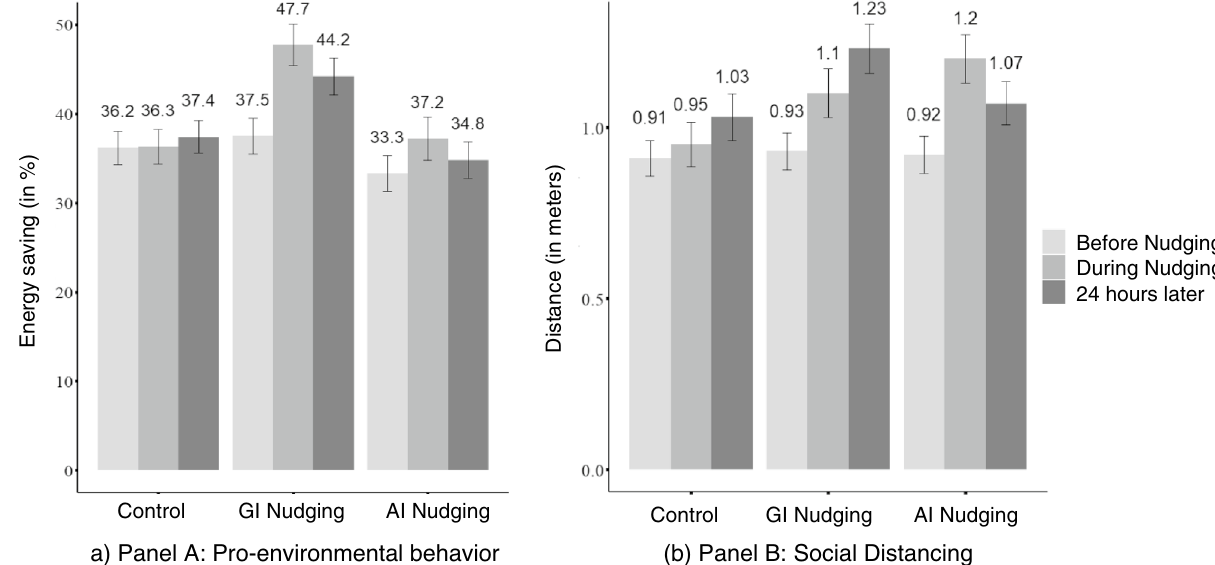
Figure 2. Indices of pro-environmental behavior (Study 1) and social distancing (Study 2) by Nudging Condition and Time. This figure displays the indices of pro-environmental behavior (reversed slider value −% energy saving in the figure search task) in Study 1 and of social distancing (distance from predecessor in the virtual shopping task) in Study 2. Indices are reported before nudging, during nudging, and 24 h later, in the control, goal inference (GI) nudging, and action inference (AI) nudging conditions. Error bars represent ± 1 standard error of the